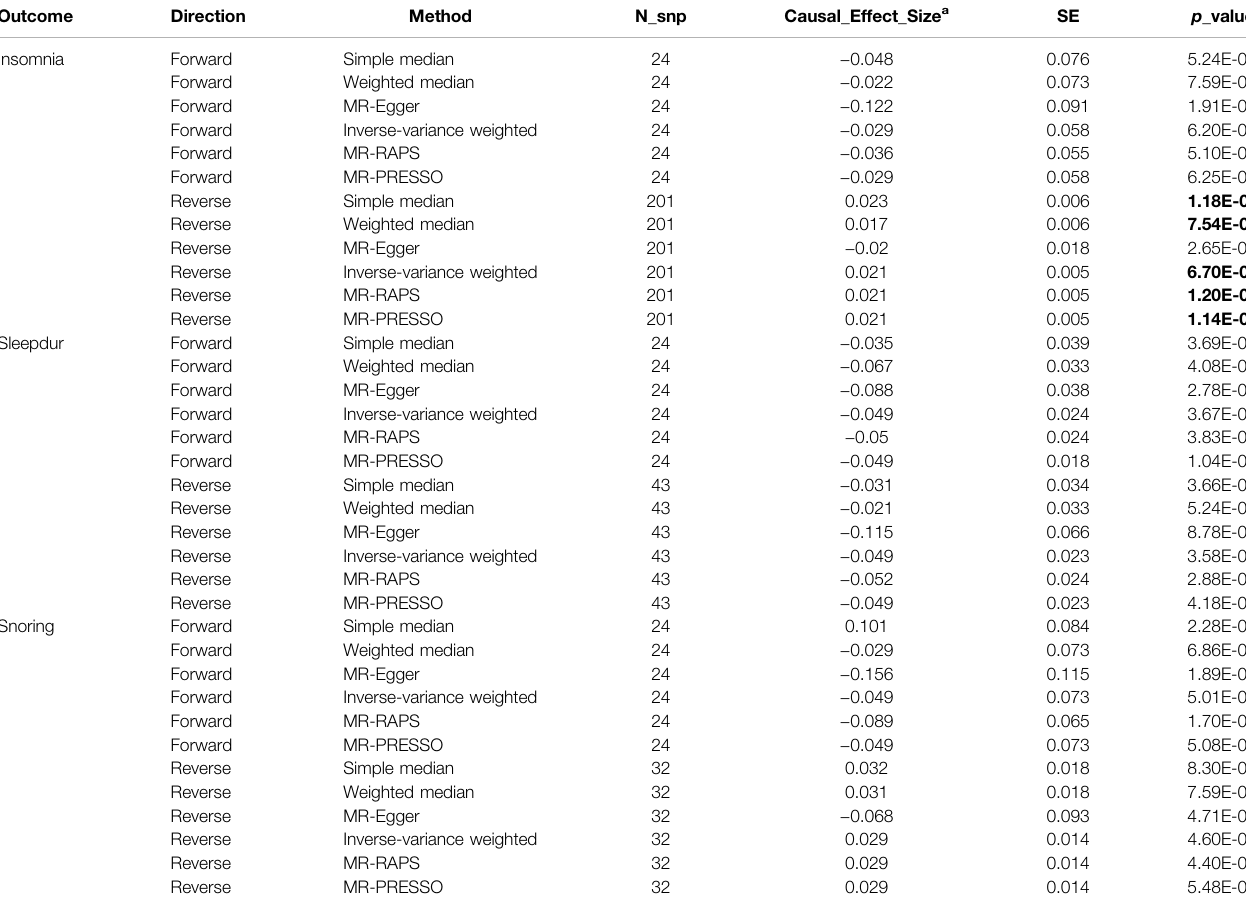
TABLE 3 | Causal inference between Alzheimer ’ s disease and sleep-related phenotypes using two-sample MR. Outcome Direction Method Insomnia